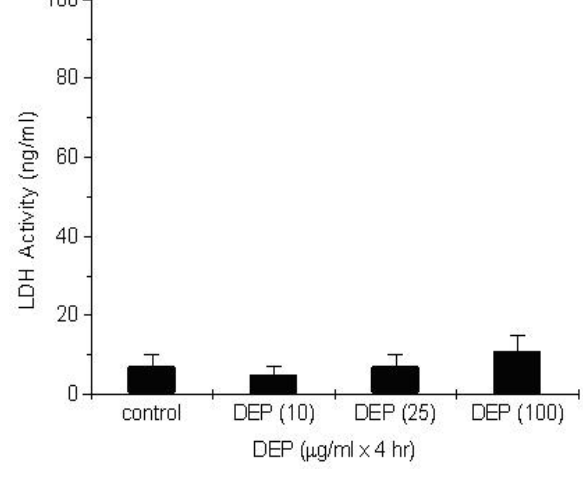
Figure 1: Cytotoxic Effect of DEP on A549 Cell Membrane Integrity. Confluent A549 cultures were treated with DEP at concentrations of 10, 25, and 100 D g/ml for 4 hr and lactate dehydrogenase activity (LDH) was measured as an indicator of cell membrane integrity. Data (ng/ml) of LDH are presented as mean ± SEM (n = 6, each